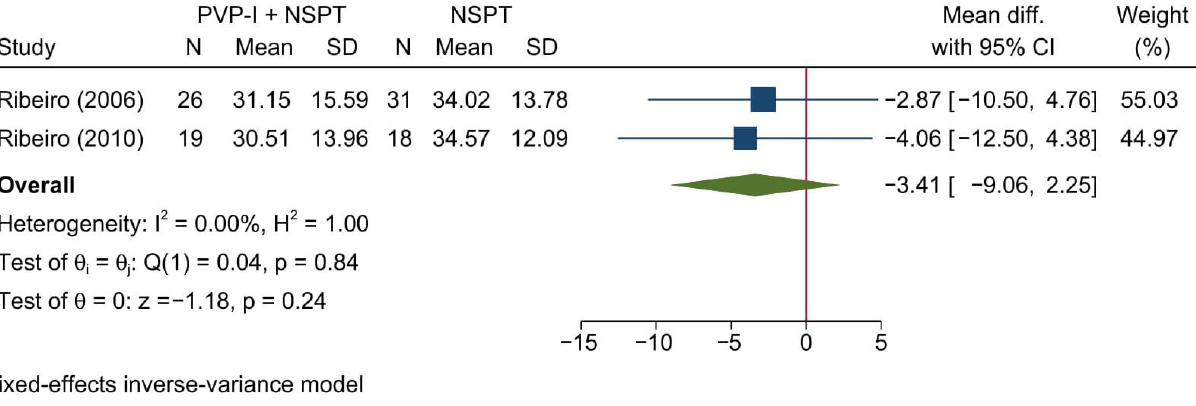
Figure 3. Forest plot showing the comparison between PVP-I + NSPT and NSPT alone regarding plaque index [31,46].